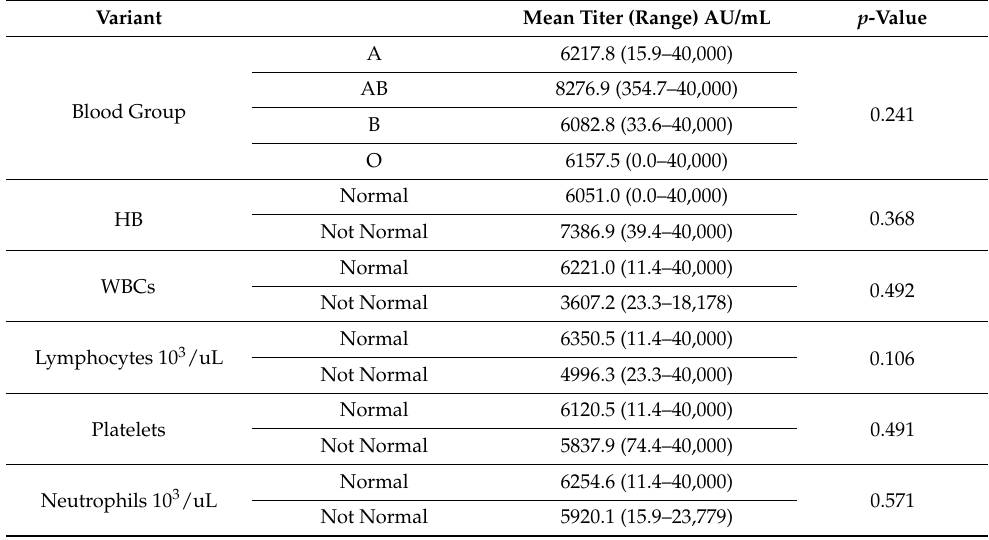
Table 8. Correlation between clinicopathological characteristics and mean titer and range of neutral- izing IgG antibodies in vaccinated